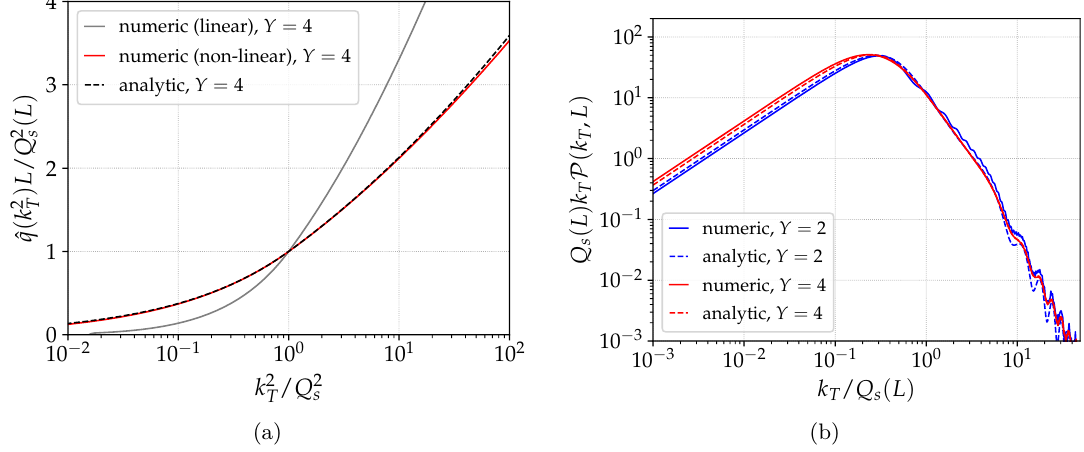
Figure 10. (Left) The dimensionless parameter ˆ q ( L, k 2 k 2 /Q 2 compared to a truncation of the divergent series. (Right) Transverse momentum broadening s T distribution after quantum evolution with running coupling, compared to two phenomenological